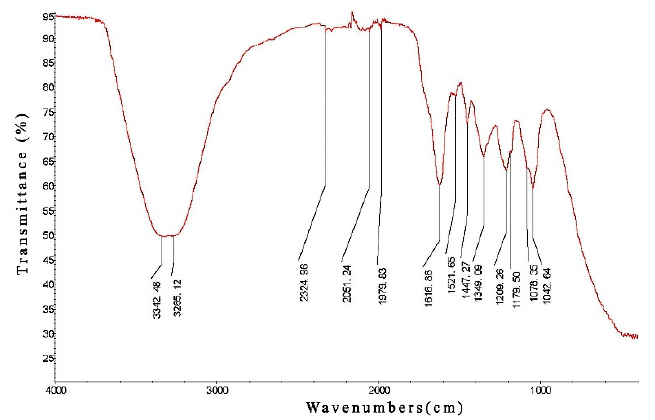
Figure 1. Infrared Spectroscopy (IR spectrum) of PCPE.